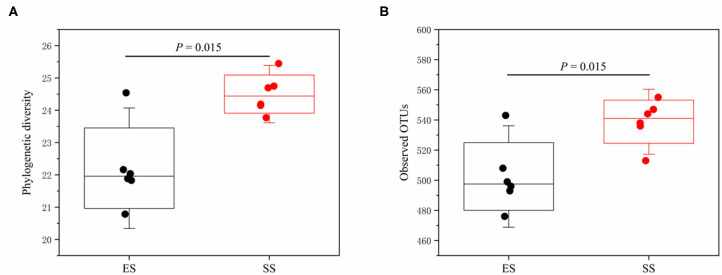
The comparisons of phylogenetic diversity (A) and observed OTUs (B) of the rumen microbiota between juvenile and sub-adult Tibetan sheep. Mann–Whitney U-test was used to test the differences between groups. Significant difference is indicated by P < 0.05.